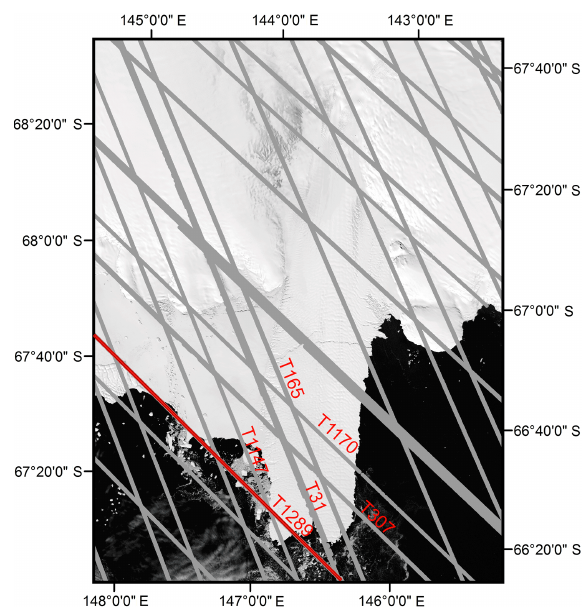
Figure 2. Spatial distribution of the ICESat/GLAS data from 2003 to 2009 covering the Mertz region. Ground tracks of ICESat/GLAS are indicated with gray lines. Track 1289 (T1289) is highlighted in red as is used in Fig. 4. The background image corresponds to band 4 Landsat 7, captured on 2 February 2003. A polar stereo- graphic projection with − 71 ◦ S as standard latitude is